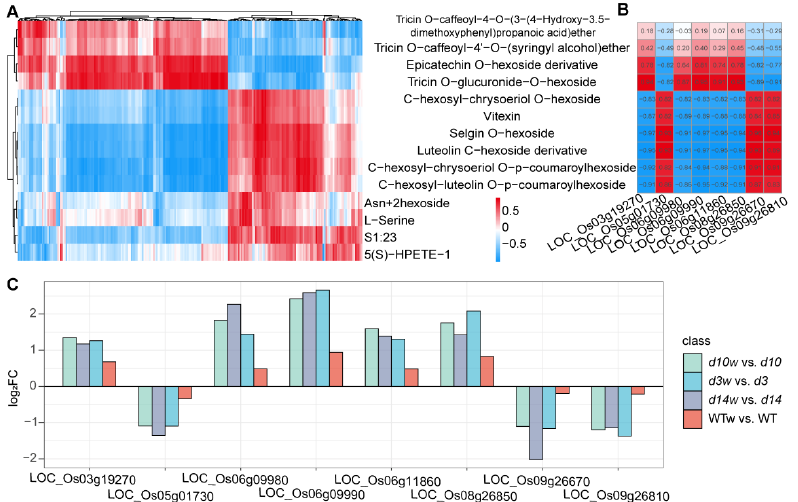
Figure 10. Candidate genes in SLs-inhibited flavones production. ( A ) Correlation coefficient clustering of DAMs and DEGs in Group 2 and Group 3. The horizontal axis represents DEGs. ( B ) Schematic representation of correlation coefficients between eight highly correlated genes and metabolites of flavones. Red represents positive correlation; blue represents negative correlation. Value in the color block was the correlation coefficient. ( C ) Log 2 (FC) of eight genes in SLs mutants and wild-type plants.